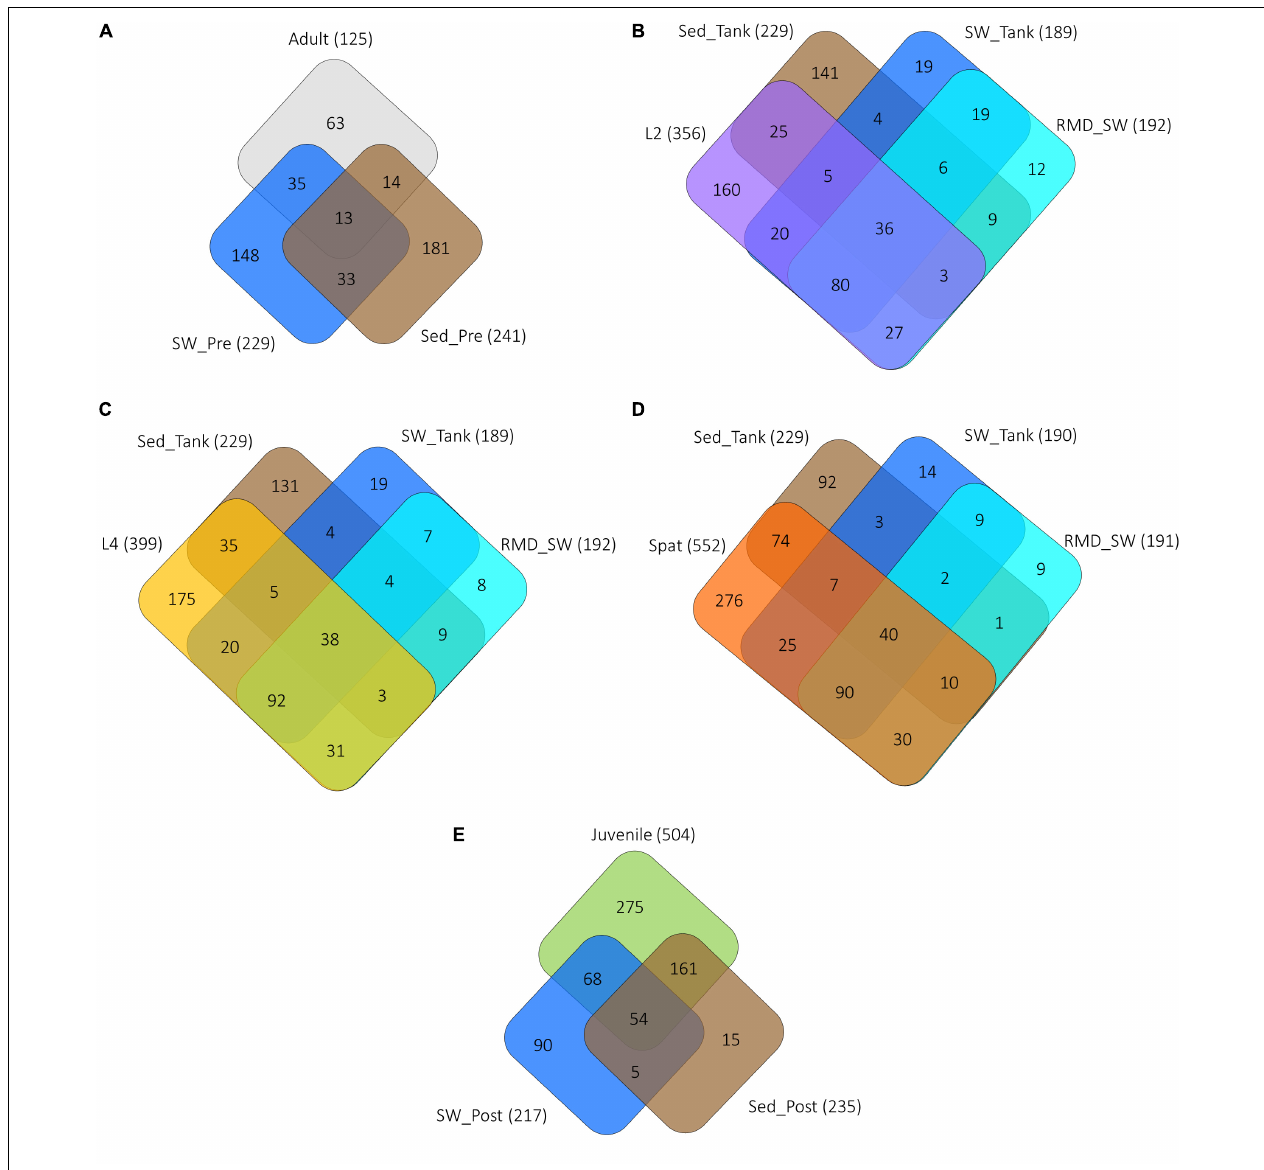
FIGURE 4 | Unique and shared OTUs between the various life history stages and the surrounding environments of seawater and sediment. (A) Adult, adult coral colonies; (B) L2, 2-day-old larvae; (C) L4, 4-day-old larvae; (D) Spat, newly settled spat, and (E) Juvenile, 6-month-old juveniles. SW, seawater from the reef; SED, sediment from the reef, RMD_SW, reduced microbial density seawater (filtered 0.22 µ m). The total number of OTUs associated with each sample type is represented in parentheses. Abbreviations are SW and Sed represent samples taken: “Pre” prior to spawning, “Tank” from the tank experiment, “Post” near juveniles on the reef.